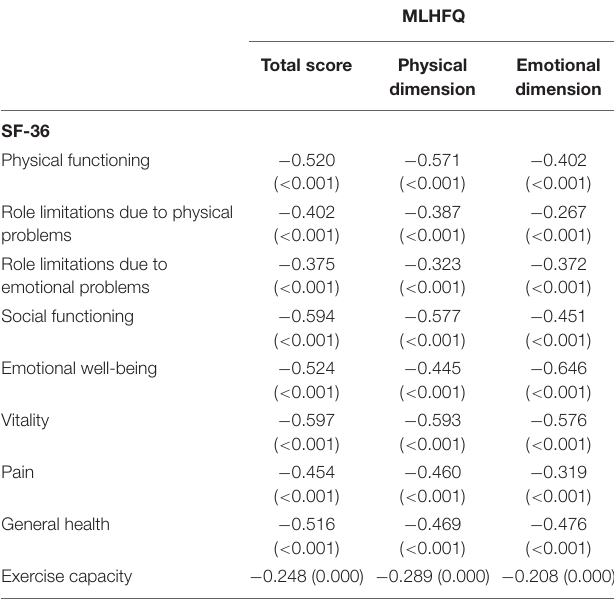
capacity in the overall